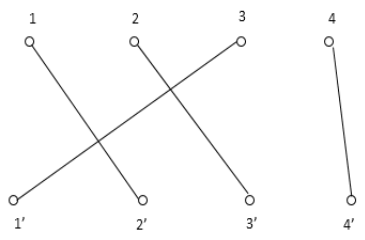
Figure 2. The perfect matching { ( 1,2 (cid:48) ) , ( 2,3 (cid:48) ) , ( 3,1 (cid:48) ) , ( 4,4 (cid:48) ) } .